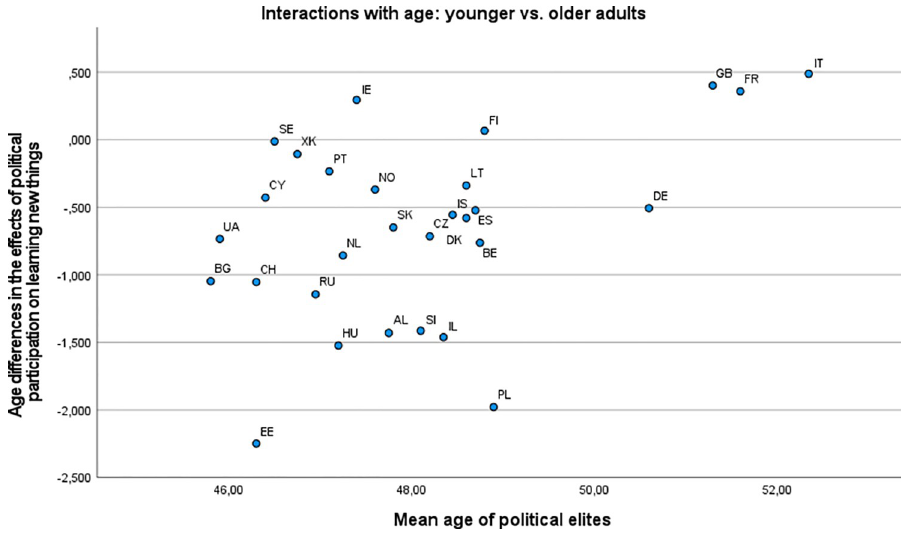
Fig 8. A scatterplot of the interactions between political participation and age (younger vs. older adults) against mean age of members of the national parliament/cabinet for learning new things as an outcome variable.